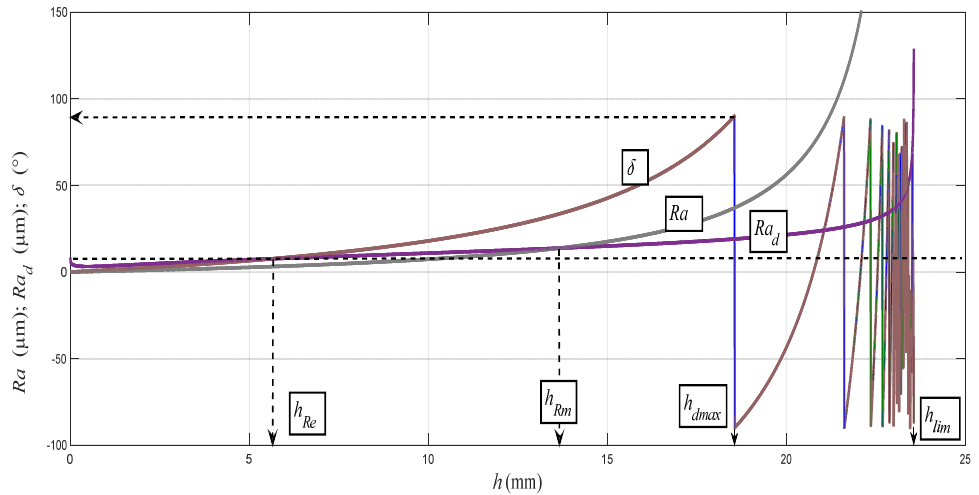
Figure 9. Topography functions ( Ra , Ra d , δ ) = f ( h ) for AISI 309 [8], Ra (gray color), Ra d (purple color), and δ (brick color).